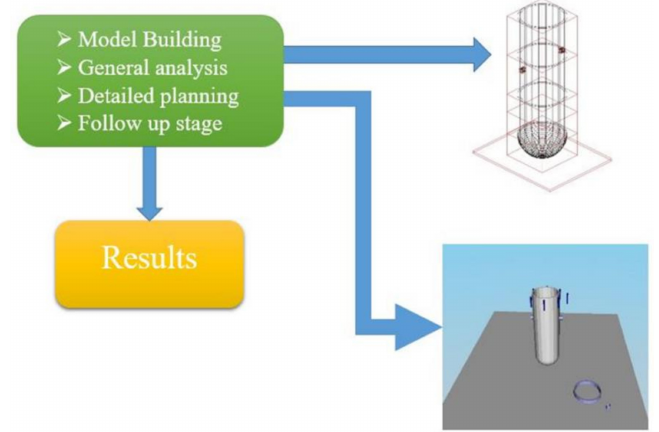
Figure 1. The main stages in the methodology of